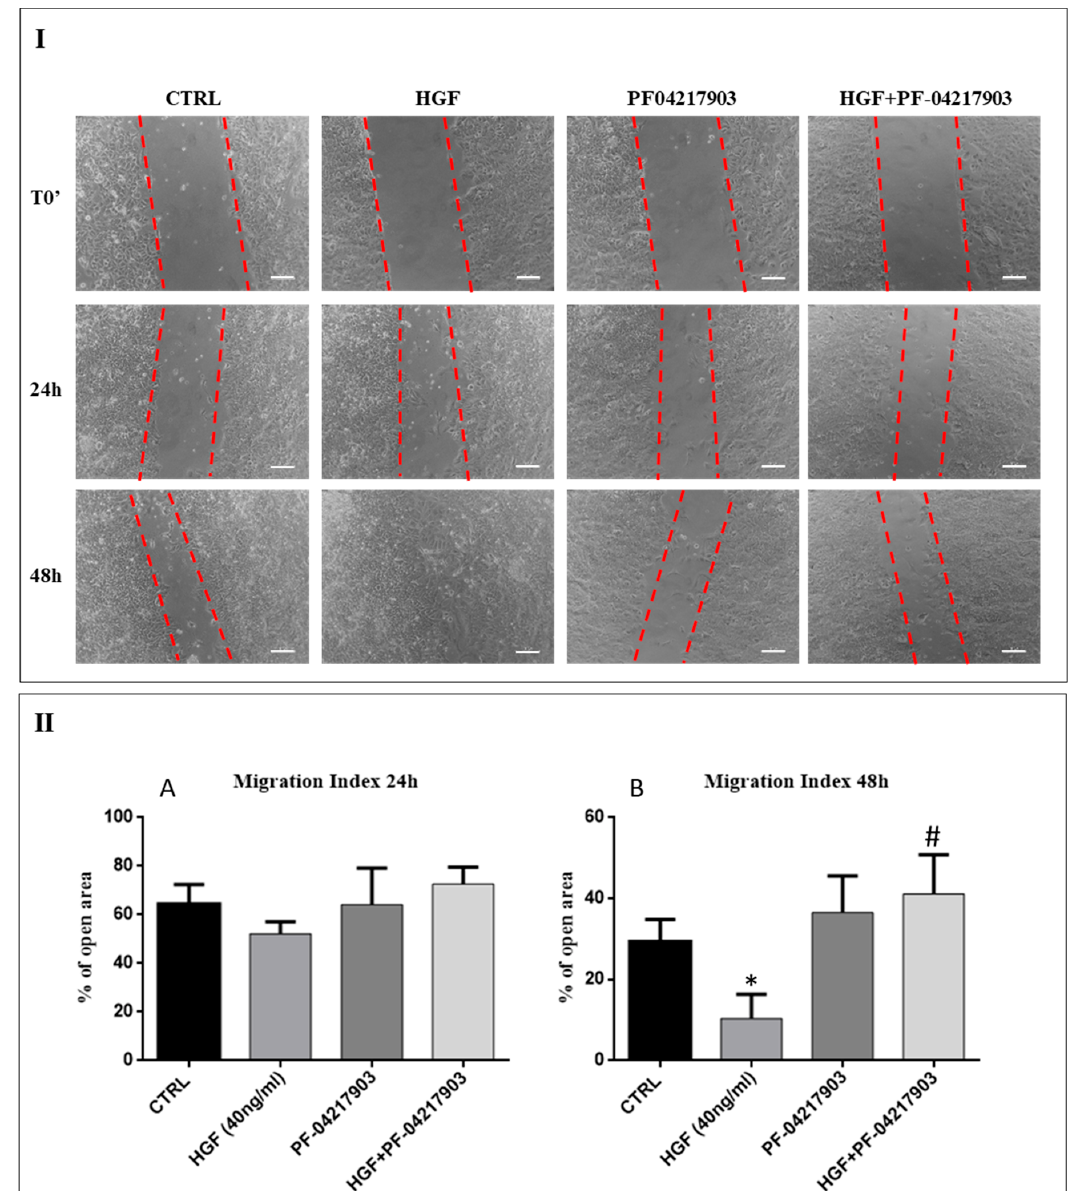
Figure 3. Role of HGF/c-MET system on NT2D1 cells collective motility: Wound-healing assay on NT2D1 cells cultured in DMEM + 2% FBS alone (CTRL), or added with HGF, PF-04217903, or HGF+PF-04217903. Four inserts were used for each experimental condition in each experiment. This experiment was performed in triplicate. (I) Representative phase-contrast images of wound-healing assay taken immediately after insert removal (T0) for wound gap (dotted red lines) measurement, or taken 24 h and 48 h after wounding. Images were photographed at 10 × magnification (scale bar: 100 µm). (II) Quantitative analysis of wound closure after 24 h ( A ) and 48 h ( B ) from insert removal. Data are expressed as the mean percentage of open residual area compared with the respective cell-free gap at T0. After 24 h the difference of open residual area was not statistically significant irrespectively to the experimental conditions. However, after 48 h of culture the decrease of open area in HGF treated wells was statistically significant with respect to the control wells (* p < 0.05). The combination of PF-04217903 + HGF abrogates the HGF-induced wound closure (# p < 0.01).